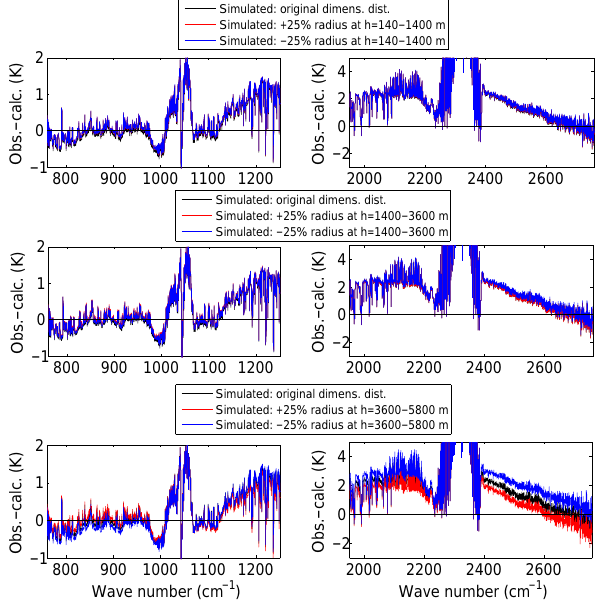
Figure 11. From the top. Left: average residuals (computed as in the previous cases) varying the average particle radii of 25% in the alti- tude range 140–1400m (blue and red), compared with the residuals obtained used the radii reported in Table 2 (black, green in previous figures). Middle plot: same as top, but changing the radii in the alti- tude range 1400–3600m. Bottom: same as before, but changing the radii in the interval 3600–5800m. Right plots: same as left, but in the spectral interval 1950–2600cm − 1 .